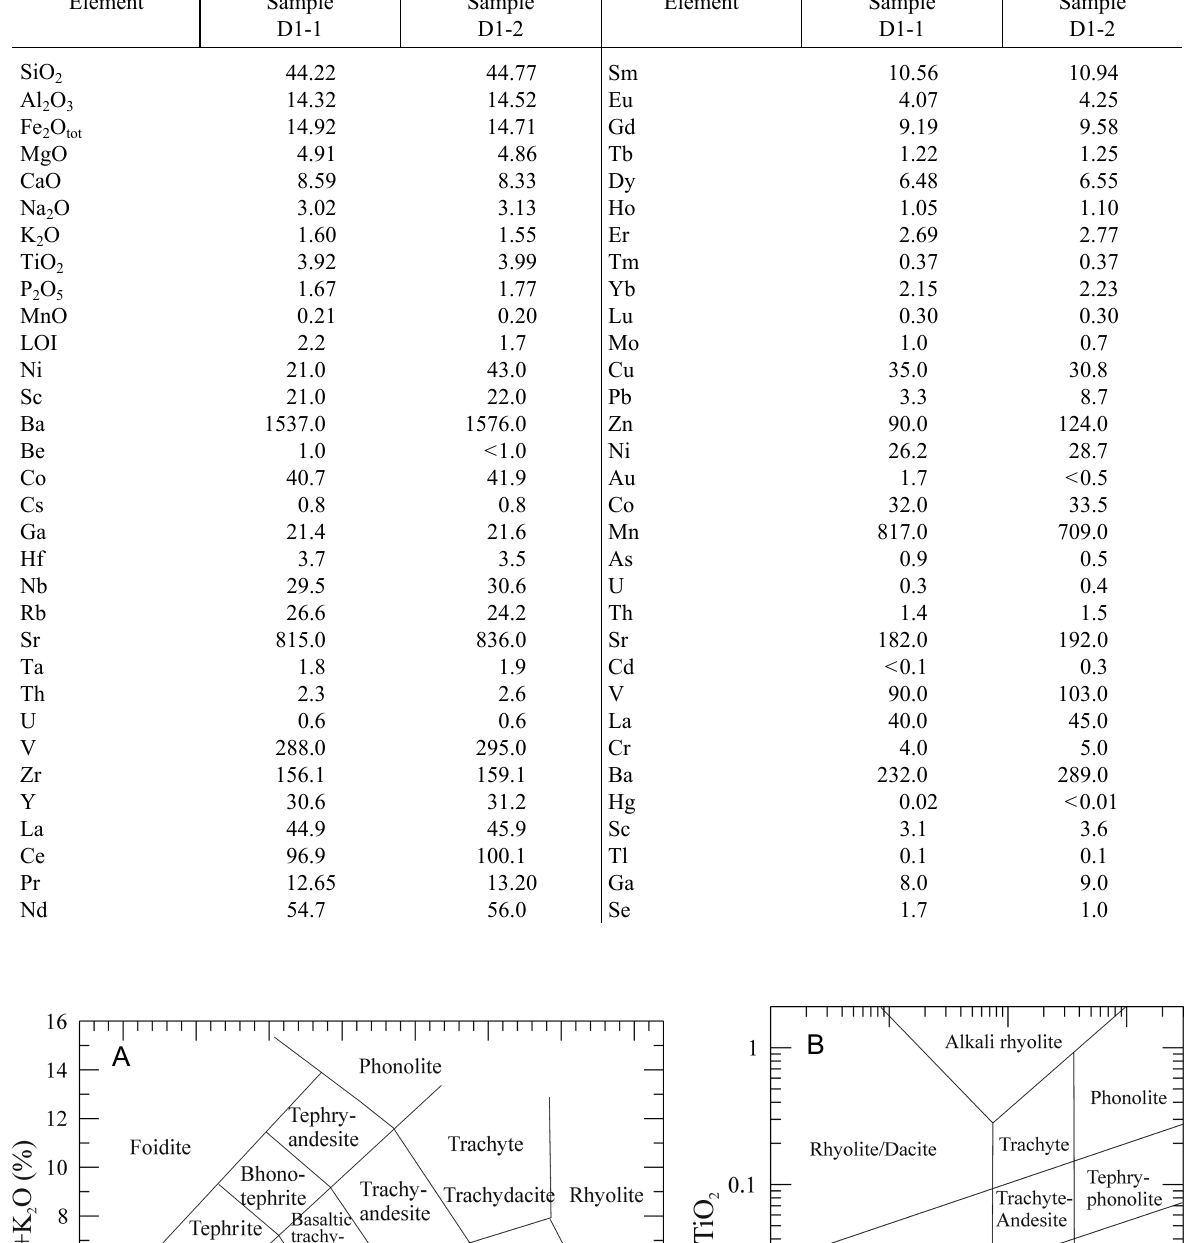
Table 3. Chemical composition of dolerites, well D1-1 (major elements in %, trace elements in ppm) Element Sample Sample Element Sample D1-1 D1-2